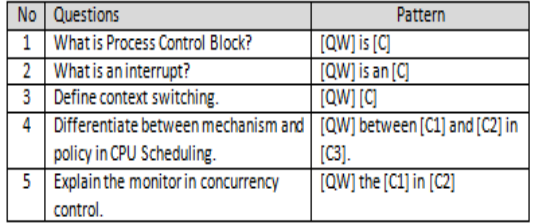
Table 3. Example of question